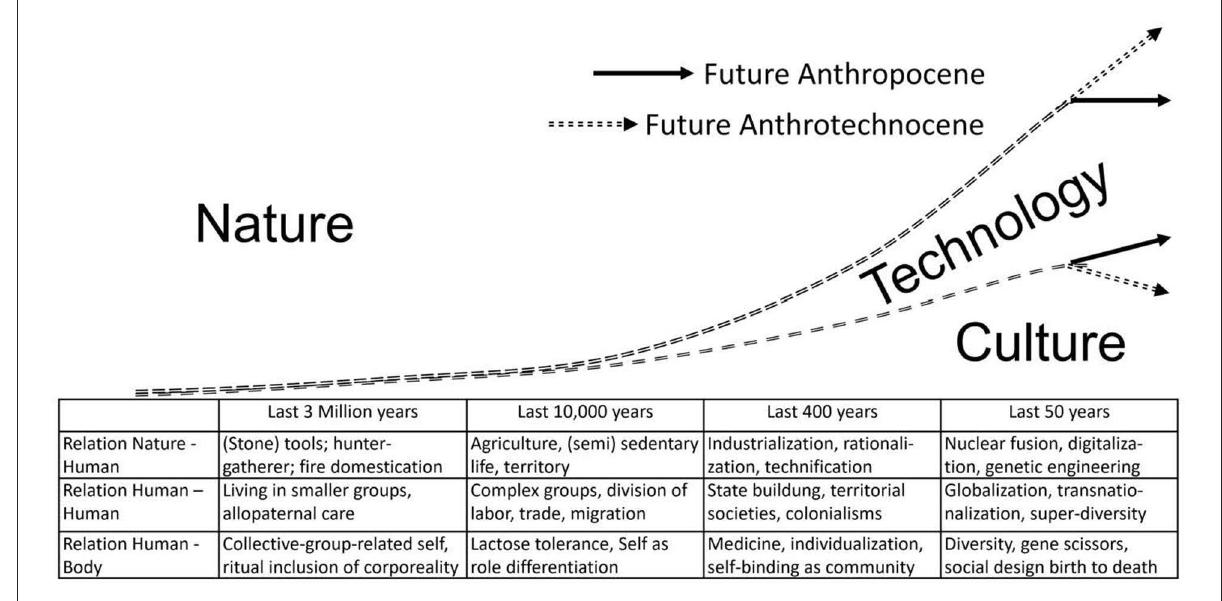
FIGURE1 Development of the relation nature-culture-technology. Source: Author’s own